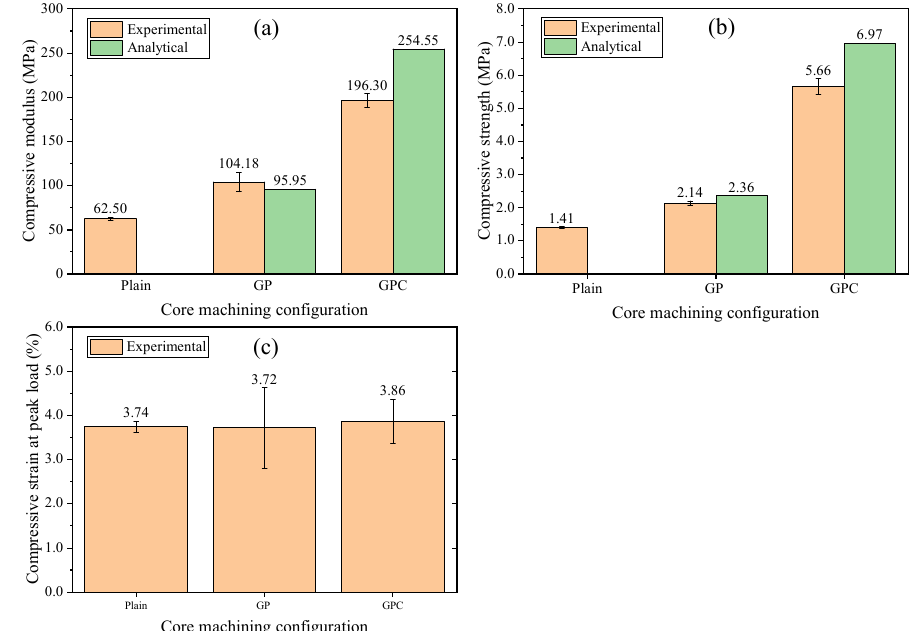
Figure 5. The compressive properties of the plain, GP, and GPC cores: ( a ) modulus, ( b ) strength, and ( c ) strain at peak load.